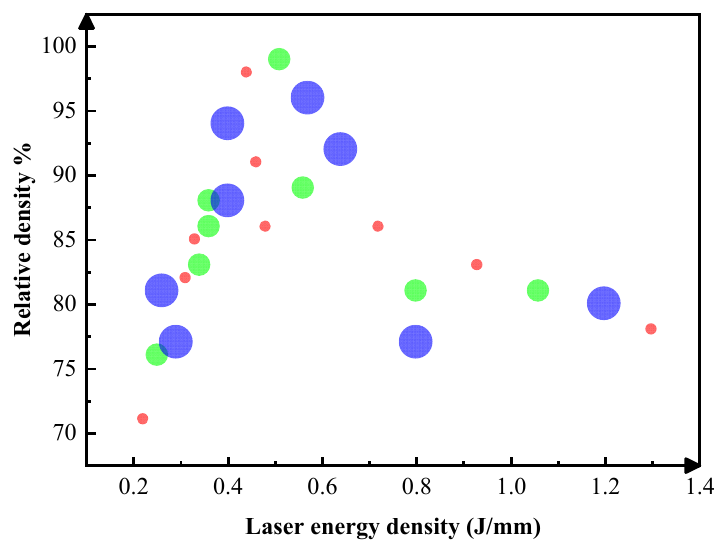
Figure 6. The process window of SLM Mo.